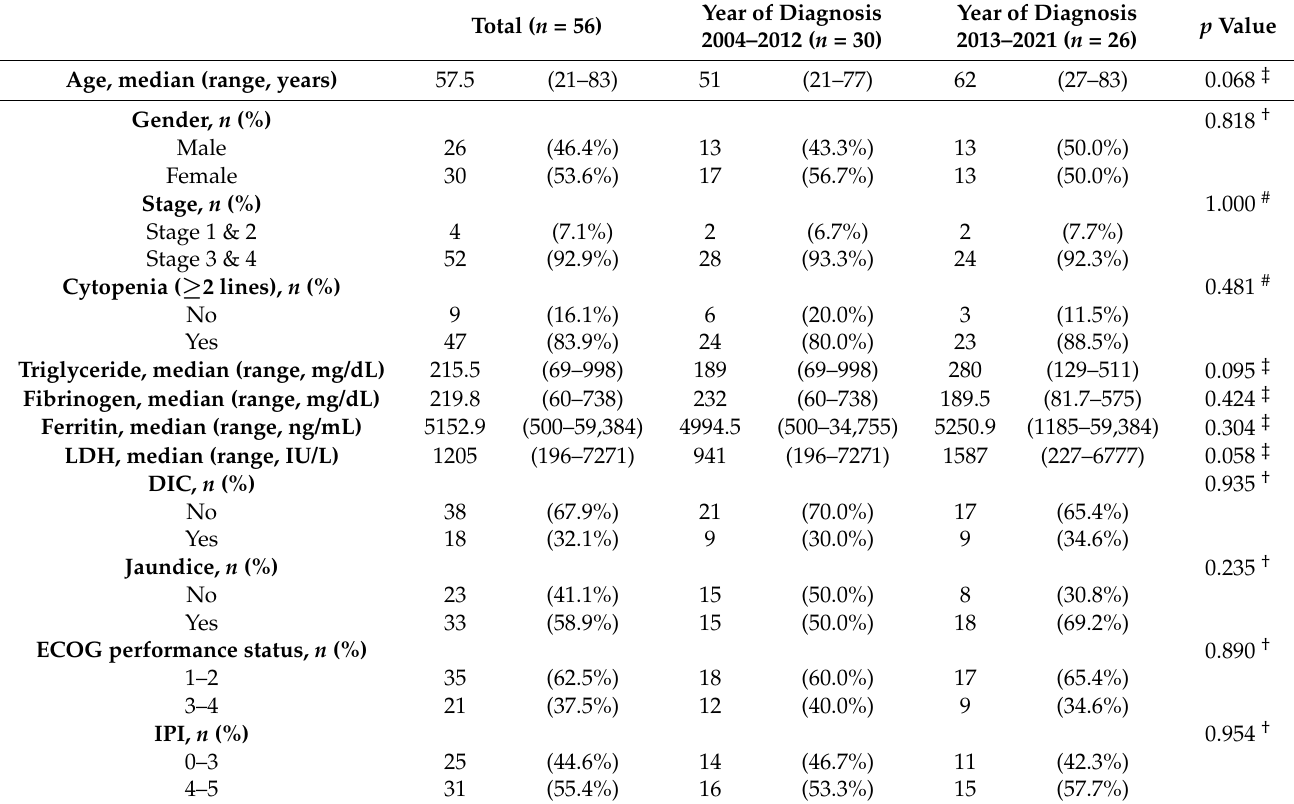
Table 1. Demographic comparisons among lymphoma-associated HLH patients diagnosed in 2004–2012 and